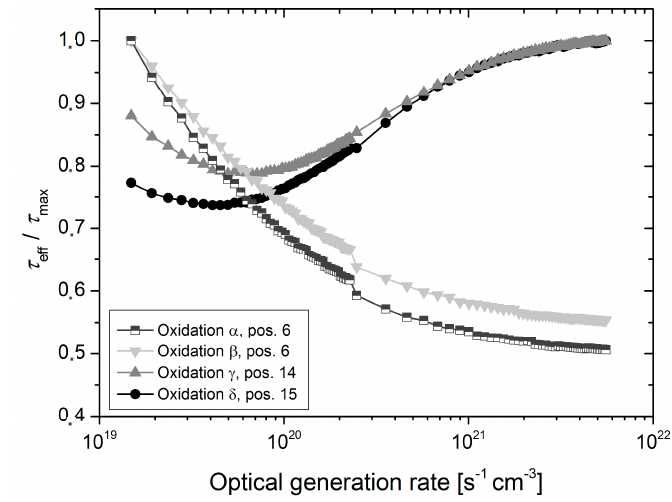
Figure 4. Effective lifetime as a function of the optical generation rate measured in the center of different wafers from the oxidation runs α , β , γ and δ , respectively.